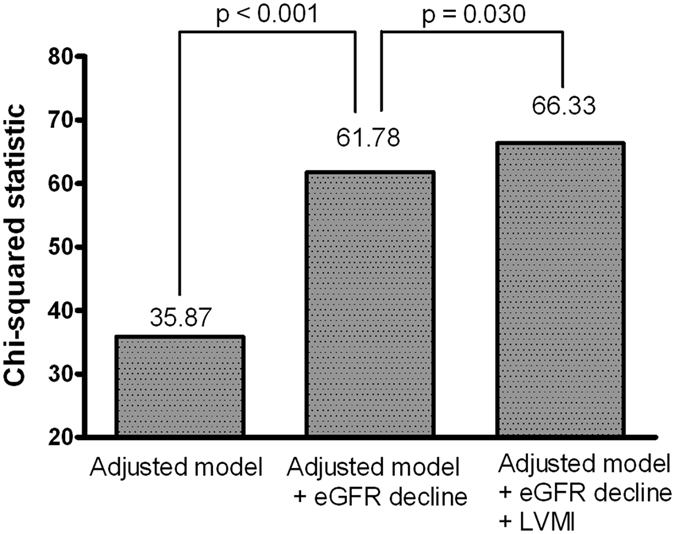
Addition of LVMI to the Cox model containing clinical variables and eGFR decline rate improved the prediction of the composite outcome.